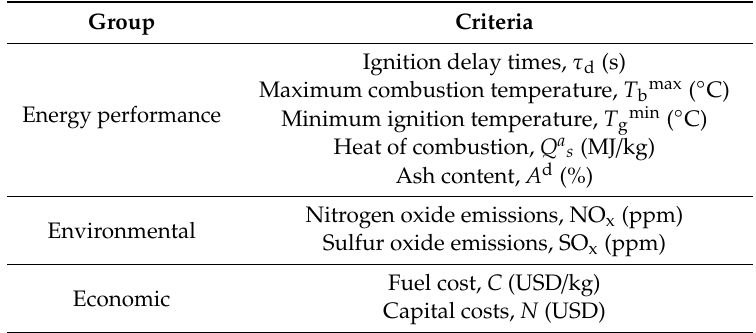
Table 4. Criteria of fuel e ffi ciency evaluation using the Weighted Sum Method